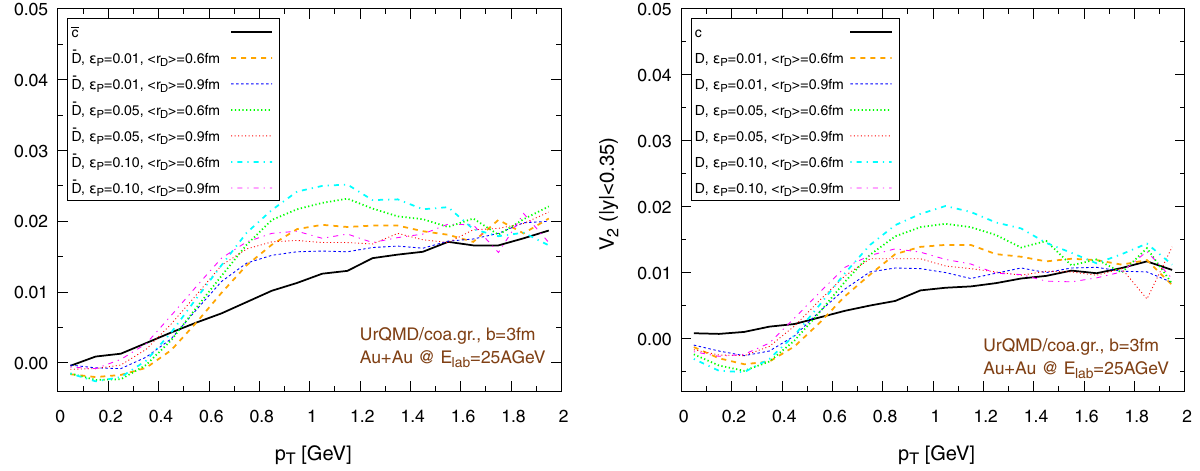
Fig. 25 Au+Au collisions at E lab = 25AGeV, b = 3fm in the UrQMD/coarse-graining approach. Elliptic flow of charm quarks and D-mesons ( | y | < 0 . 35). We explore the effect of different choices of